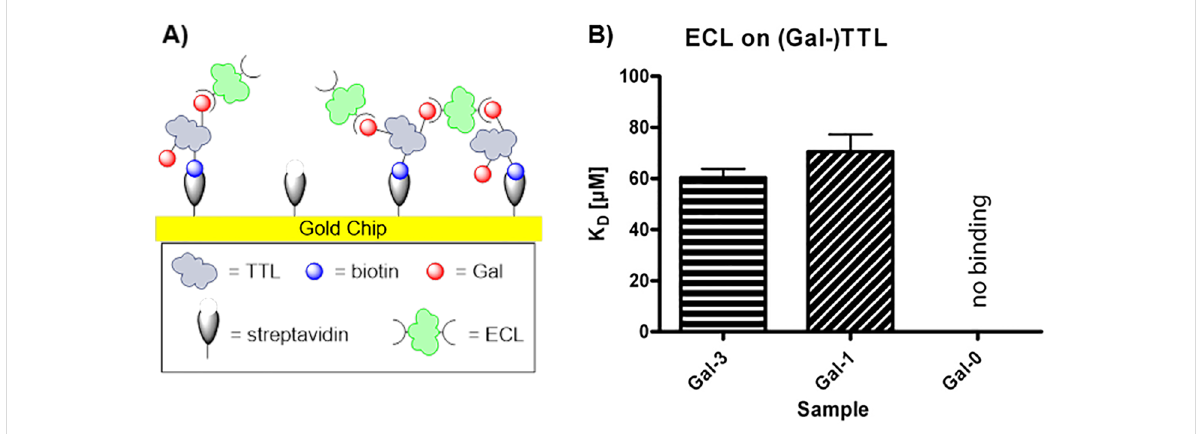
Figure 2: SPR measurements: A) set-up showing different binding events of the double-functionalized TTL to ECL; B) K D -data obtained for binding of Gal-0 , Gal-1 and Gal-3 .